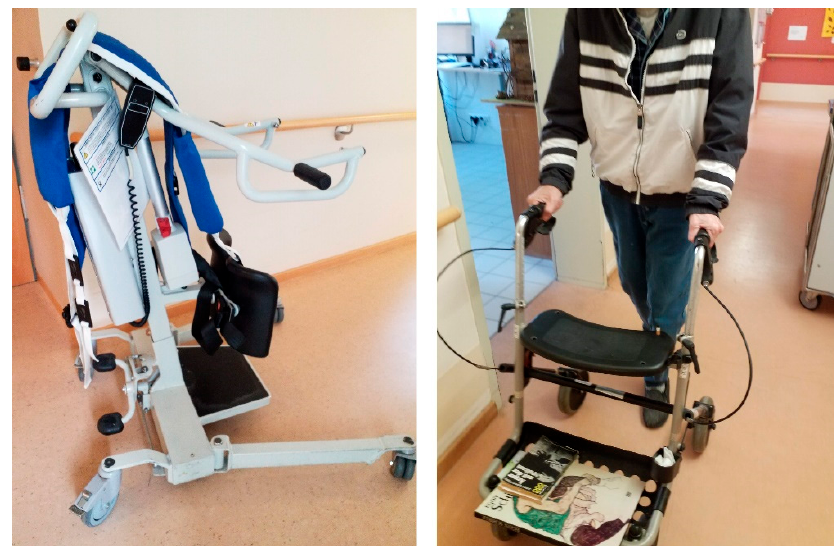
Figure 2. Examples of photographs by staff of how to enhance PA vs. photographs by residents of how enhance their PA.